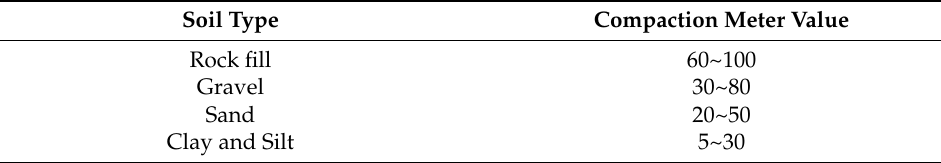
Table 4. Typical CMV values.